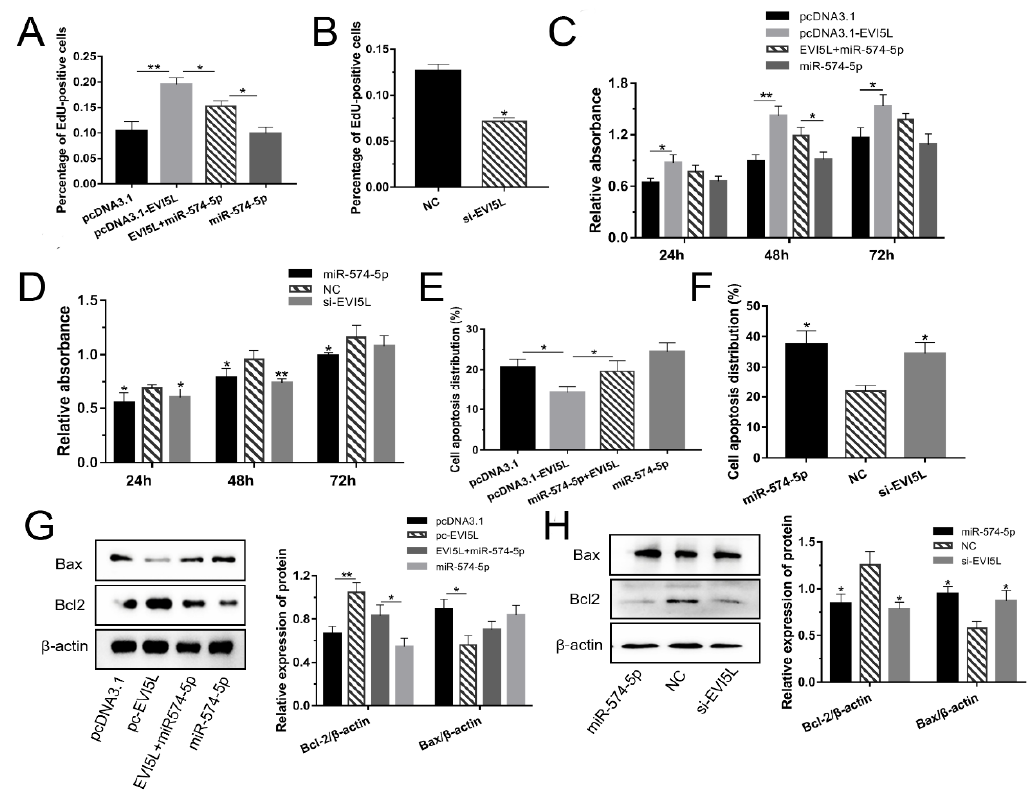
Figure 3. EVI5L promoted the growth of GMECs. ( A , B ) EdU was used to analyze cell proliferation when the GMECs were cultured for about 24 h after transfection.( C , D ) Using CCK-8 to test the activity of GMECs which were cultured for 24, 48 and 72 h after transfection. ( E , F ) Flow cytometry was performed to analyze cell apoptosis after transfecting for about 24 h. ( G , H ) WB assay was conducted to investigate the protein expression of Bcl2 and Bax in the GMECs. Pc- EVI5L : overexpression EVI5L plasmid; pcDNA3.1: control group; NC: negative control; si- EVI5L : small interfering RNA; miR-574-5p + EVI5L : miR-574-5p + pcDNA3.1- EVI5L . ** means significant di ff erence ( p < 0.01), * means significant di ff erence ( p < 0.05).